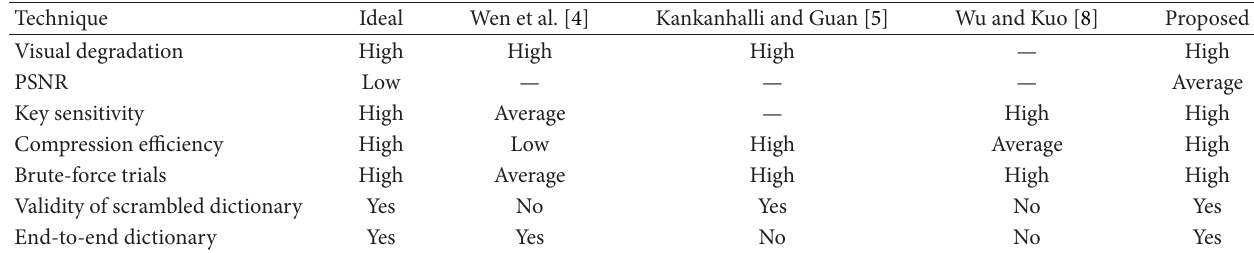
Table 3: Comparison of the proposed